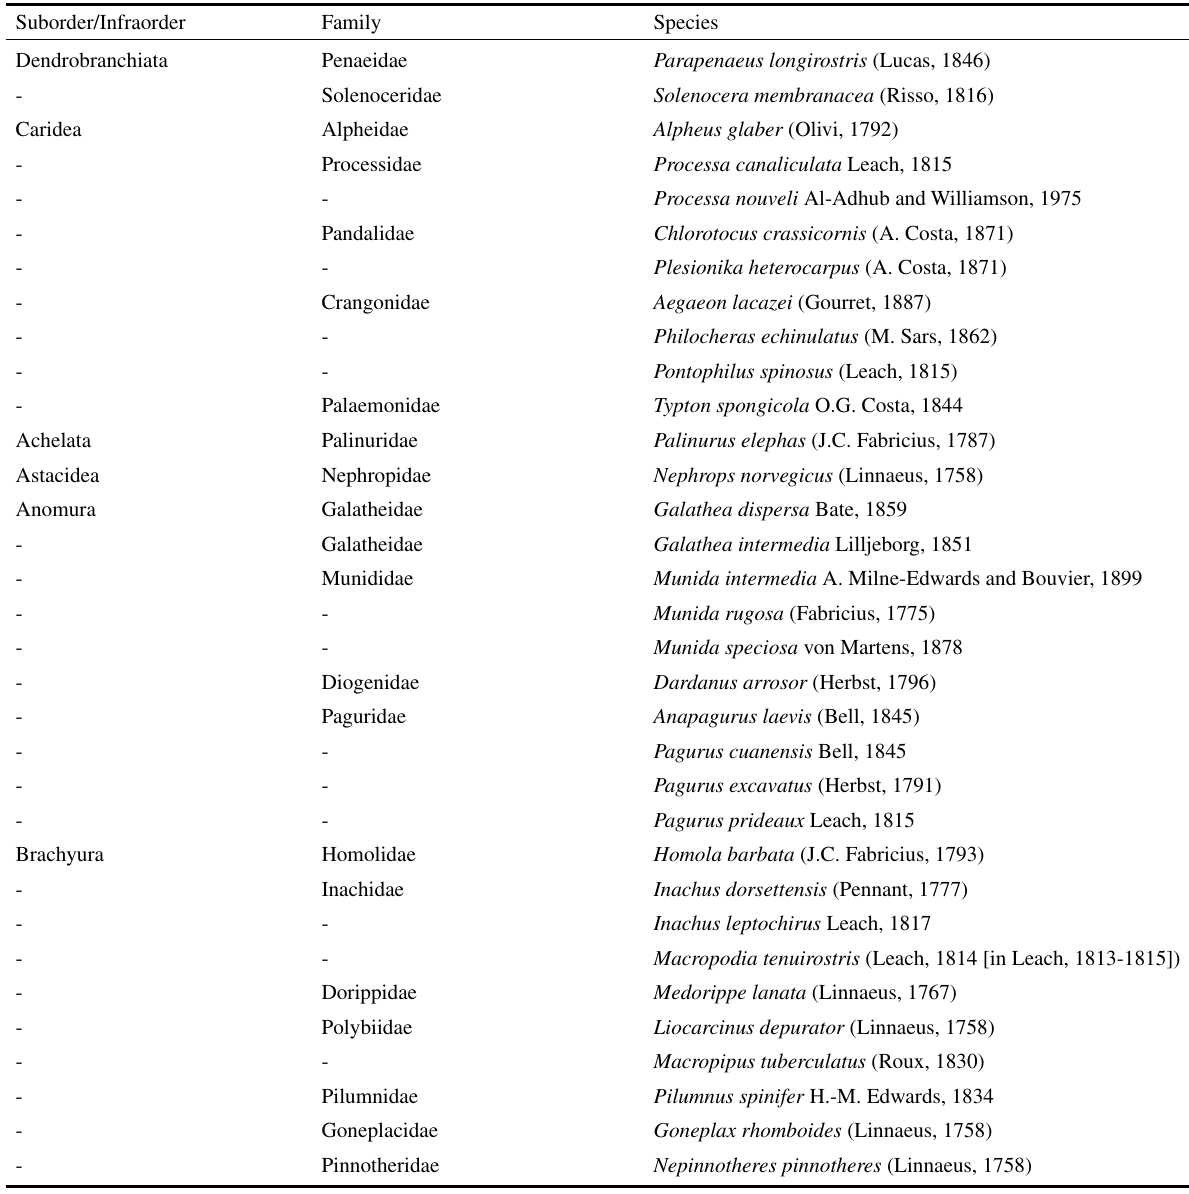
Table 1. – List of the decapod crustacean species captured during this